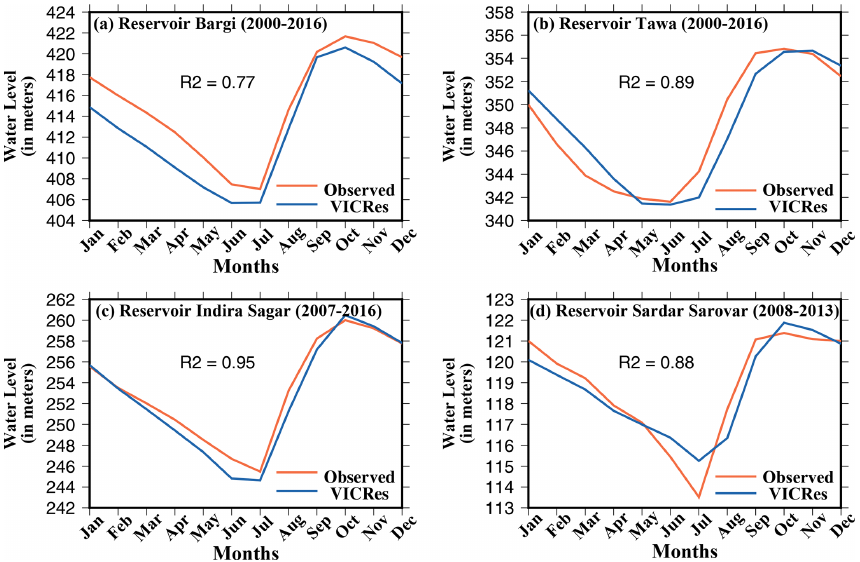
Figure 8. Comparison of observed and the VIC-Res model simulated reservoir water levels for four reservoirs in Narmada River Basin.